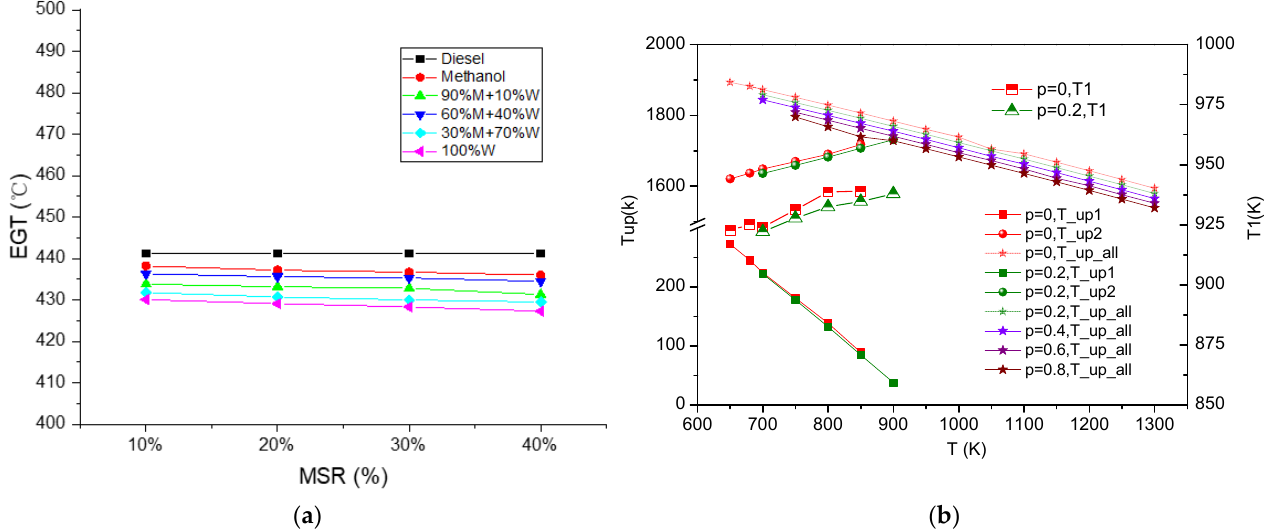
Figure 7. The influence of different water–methanol mixture fuel ratios on exhaust gas temperature (a) EGR data of experiment, (b) EGT data of simulation.